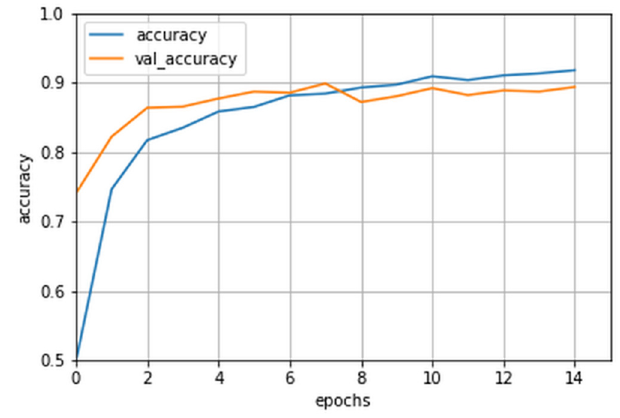
Figure 5. Training and validation set accuracy over epochs (Exp2).